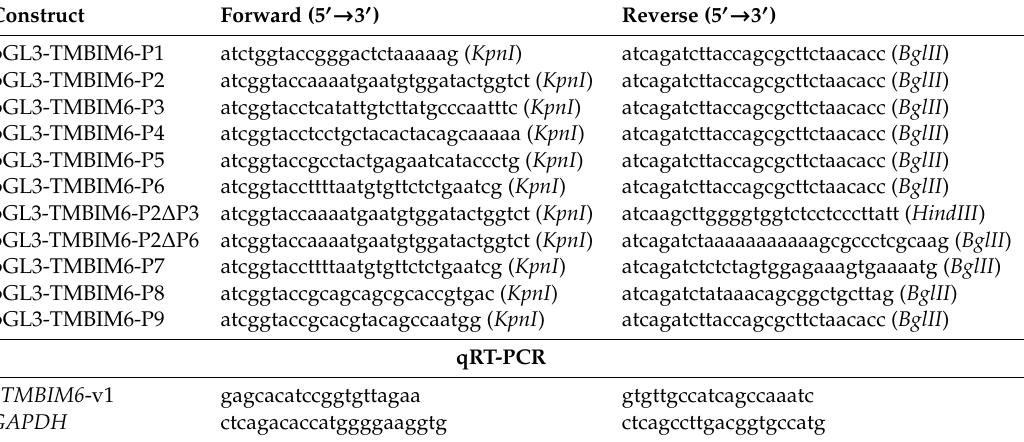
Table 1. Primers used for the reporter construct and quantitative real-time PCR